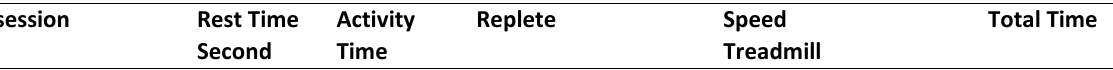
Table1. High intensity interval training